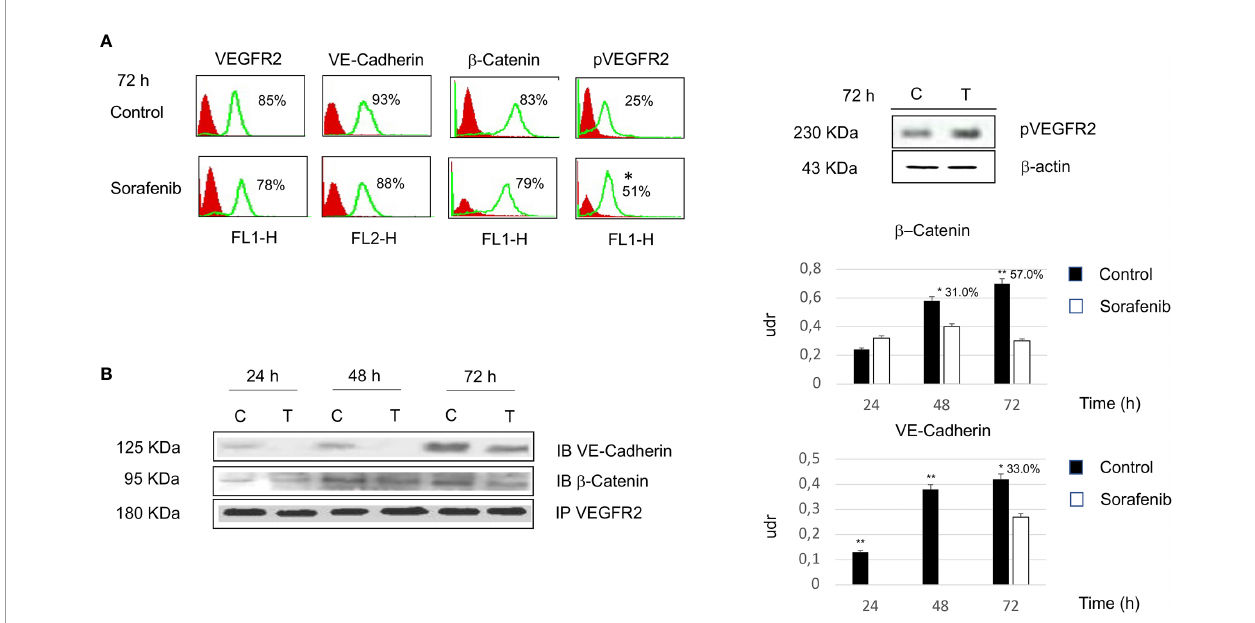
FIGURE 2 | Flow cytometry analysis of VEGFR2, VE-cadherin, b -catenin and pVEGFR2 in untreated and sorafenib treated H295R cells. Only pVEGFR2 was signi fi cant in sorafenib treated sample (p<0.05). Western blot analysis of pVEGFR2 at 72 h is shown on the side (A) . Coimmunoprecipitations of VE-Cadherin and b -Catenin with VEGFR2. On the right, graph bars corresponding to densitometric analysis of b -Catenin and VE-Cadherin. Next to the bar graphs are reported the percentage of coprecipitate proteins at 24, 48 and 72 h. The samples treated with sorafenib and marked on top of the bar are considered statistically signi fi cant (*p<0.05;**p<0.01) (B) . The values of fl ow cytometry analysis and coimmunoprecipitations are expressed as the mean ± SE (standard error) from three independent